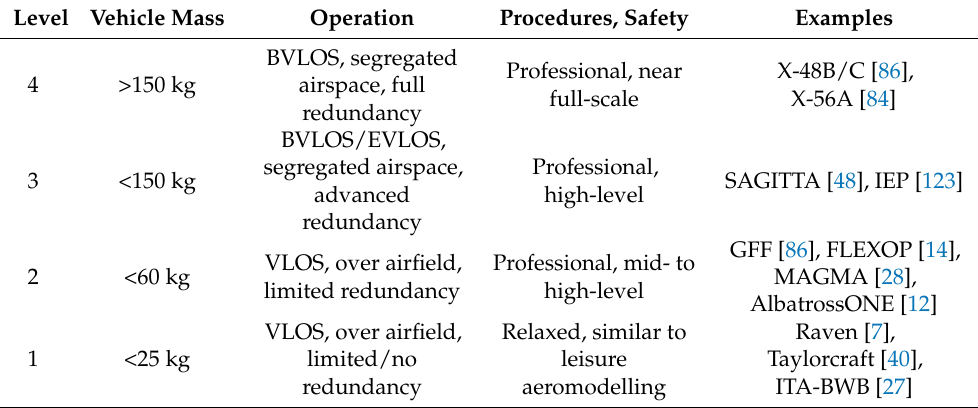
Table 5. Rough classification of different approaches to SFT according to operation and safety